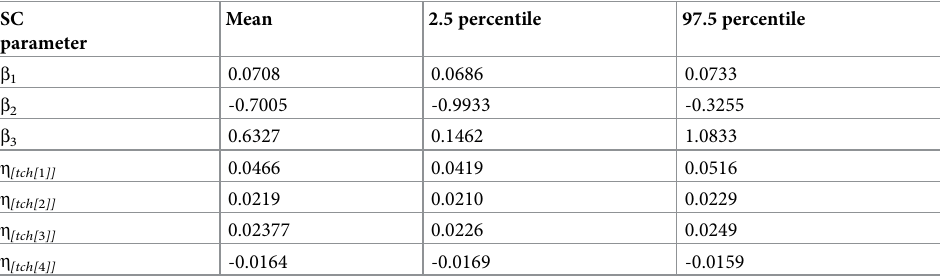
Table 11. Posterior mean parameter estimates for the SC mobility model 1.